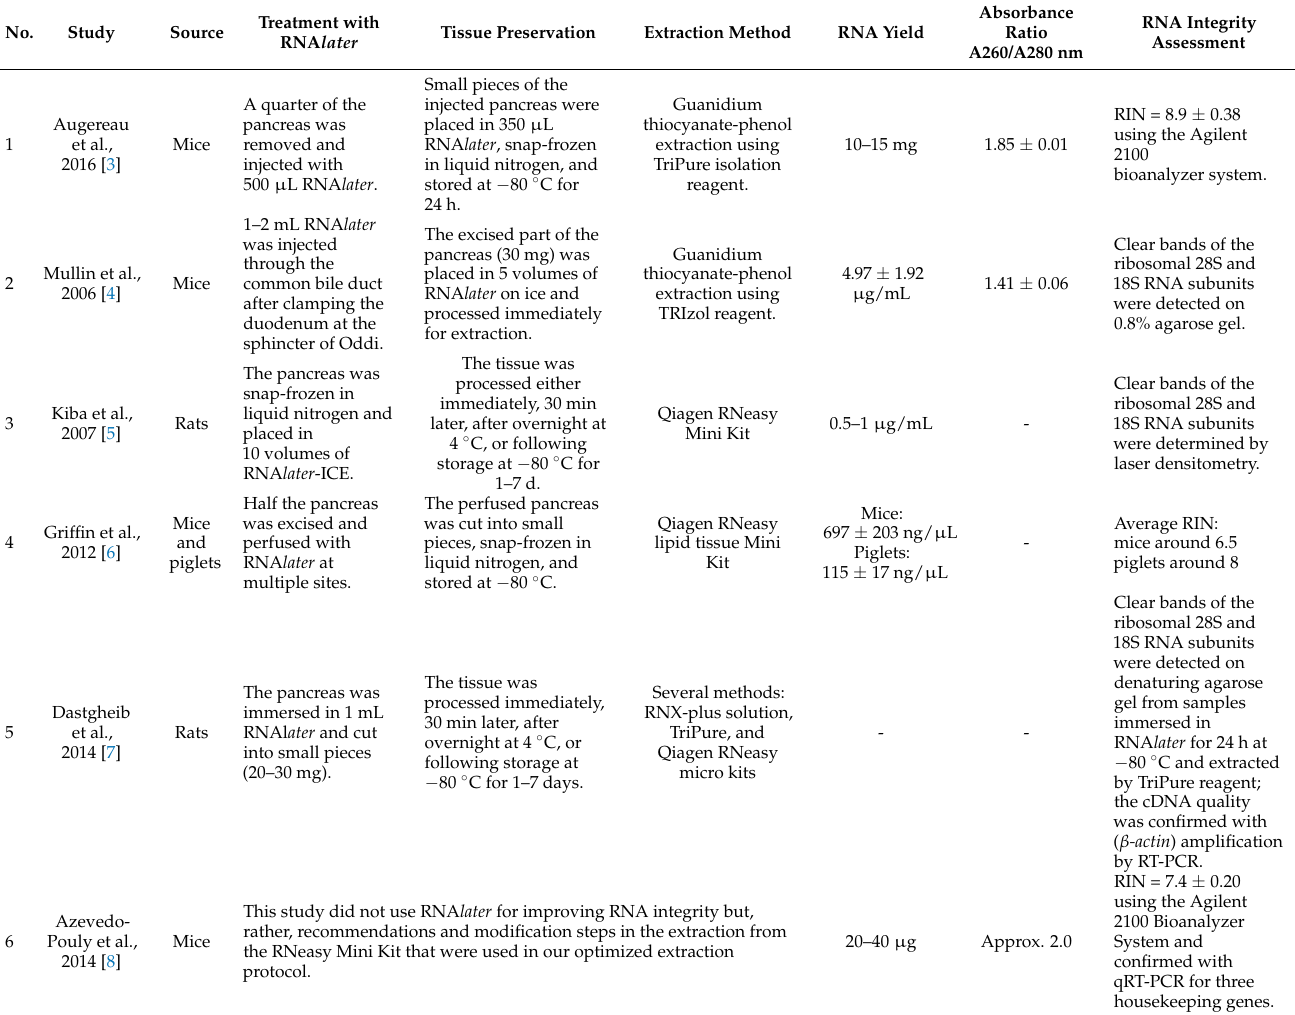
Table 1. A summary of published protocols for pancreatic RNA